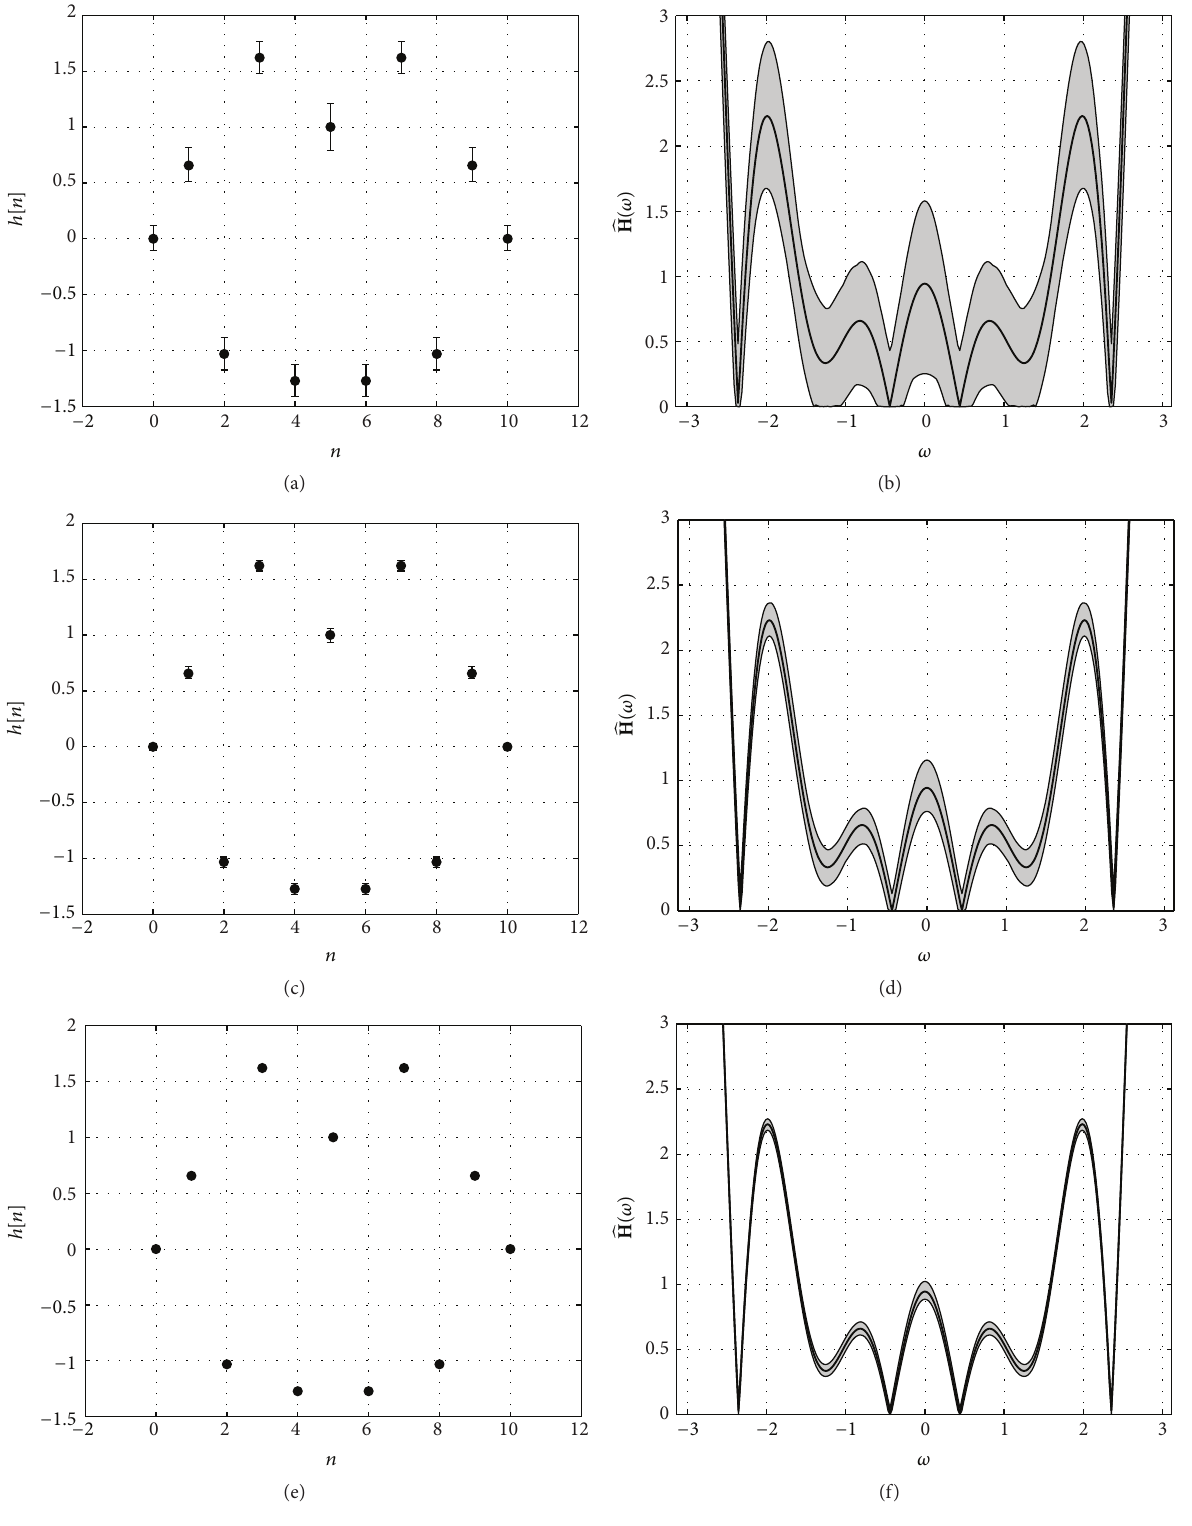
Figure 6: (a), (c), and (e) Estimated channel’s impulse response for SNR = 0dB, SNR = 10dB, and SNR = 20dB, respectively. (b), (d), and (f) Estimated channel’s frequency response for SNR = 0dB, SNR = 10 dB, and SNR = 20 dB, respectively. In all cases the length of the channel is = 4 pilot subcarriers are used in the 𝐿 = 11 , the length of the DCT1 is 𝑁 = 256 , and 𝑁 𝑝